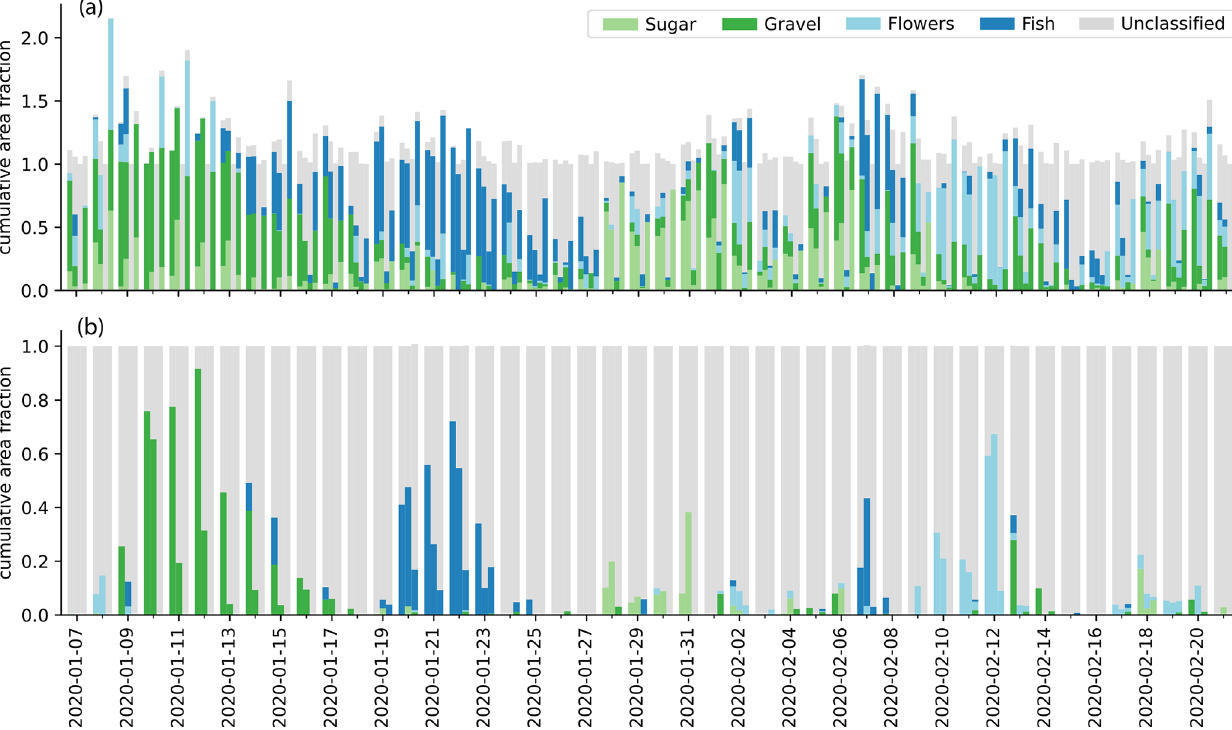
Figure 7. Time series of the area fraction covered by each pattern as identified in the workflows EUREC 4 A VIS (first bar), EUREC 4 A IR (second bar), EUREC 4 A ICON (third bar) and the deep neural network trained for the infrared classification of cloud patterns (fourth bar in a ) within the area of 10–20 ◦ N, 58–48 ◦ W. Thresholds of 0.1 (a) and 0.5 (b) have been applied to the percentage of agreement of the manual classifications and visualize that the overlap of different categories (cumulative area fractions above 1) is eliminated in the latter. Please note that the date format in this figure is